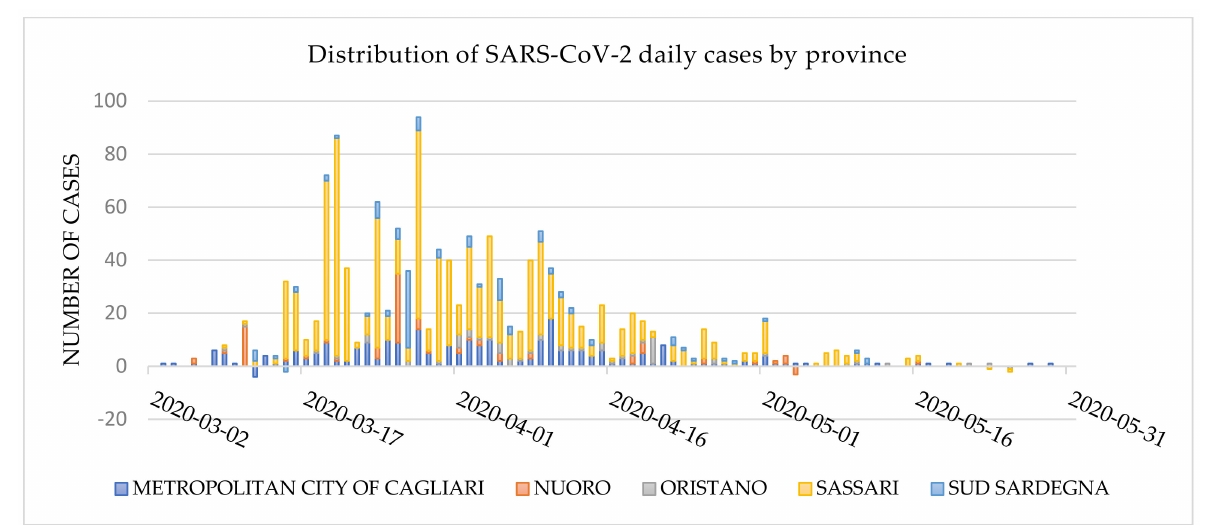
Figure 1. Daily distribution of SARS-CoV-2 cases by Sardinian district as of 31 May 2020 (data source: Civil Protection